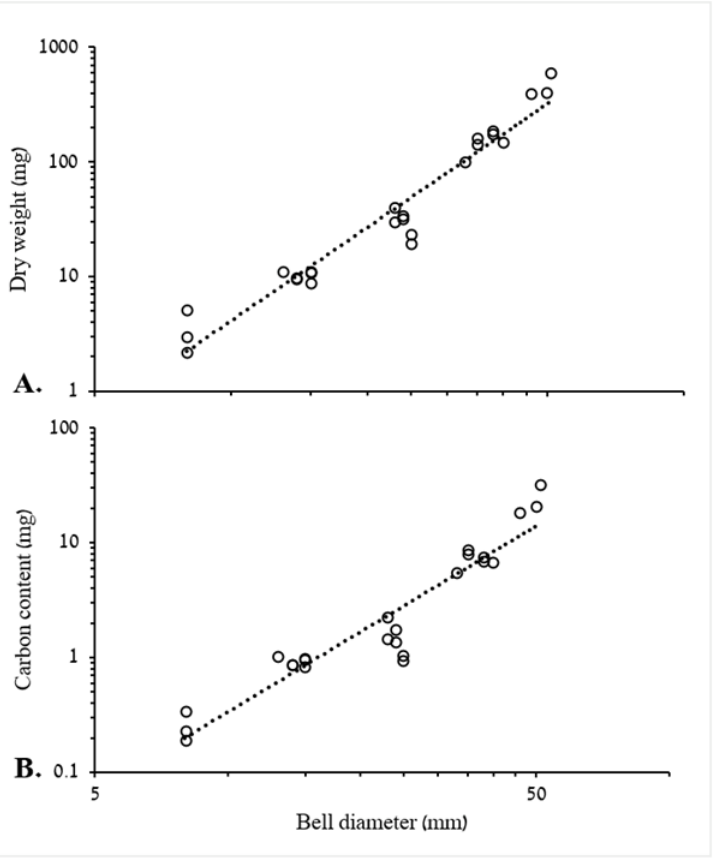
Figure 1. Log–log plots of the relationship between bell diameter of R. nomadica with ( A ) dry weight (DW) and ( B ) carbon content (C) ( n = 24). ( A ) DW = 0.008*BD 2.7075 , R 2 = 0.943. F 1, 22 = 363.8, p < 0.001. ( B ) C = 0.0016*BD 2.3176 , R 2 = 0.896. F 1, 22 = 188.5, p < 0.001.